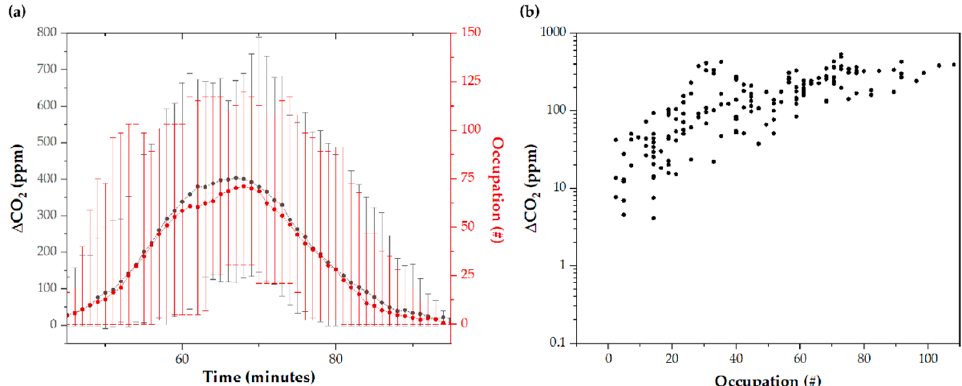
Figure 5. ∆ CO 2 increment and tram occupancy as ( a ) a function of time, and as ( b ) a function of tram occupancy. The error bars correspond to the difference between the maximum/minimum data and the average data of all the studied routes.